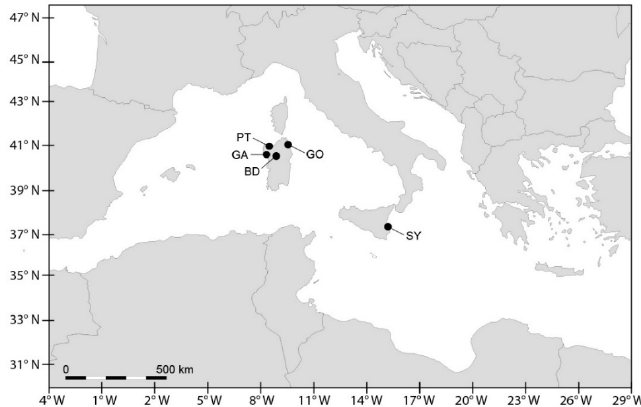
Figure 1. Location of the study area and sampling sites. (Lake Bidighinzu = BD; Gulf of Olbia =